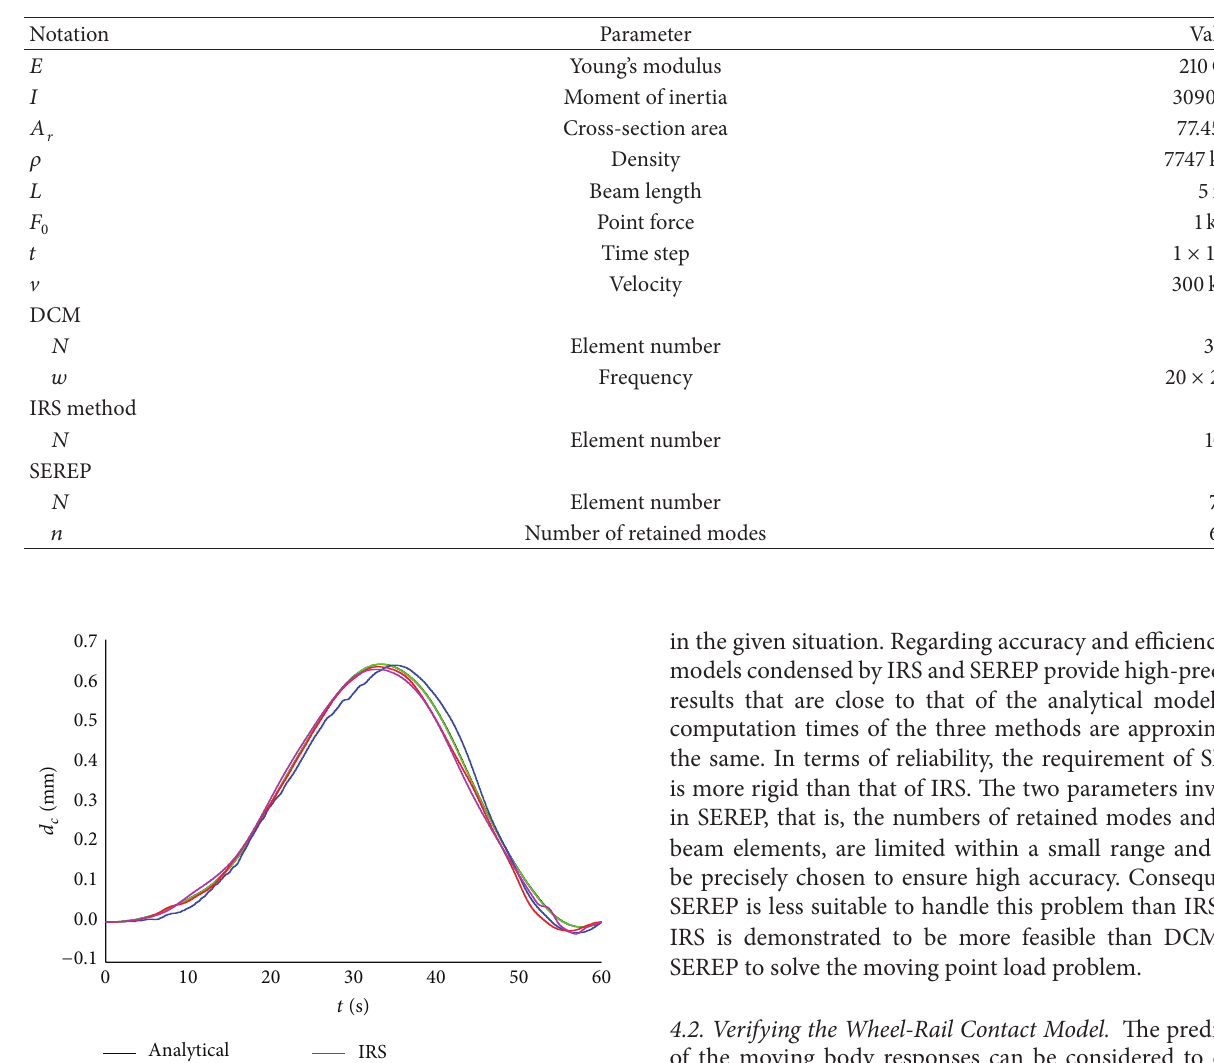
Table 1: Moving load model parameters.